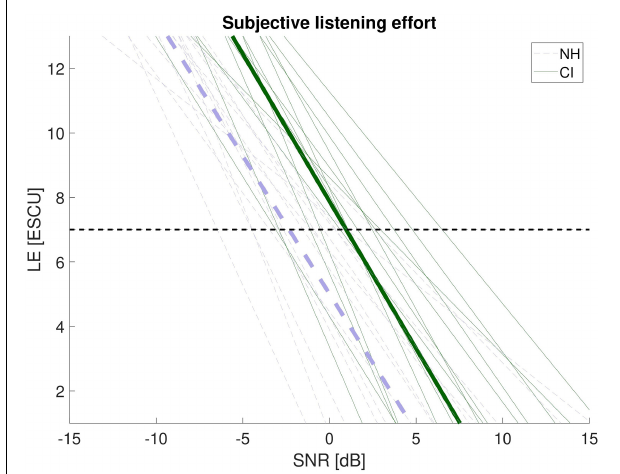
FIGURE 1 | Estimated speech recognition functions for the CI recipients (green) and the NH listeners (violet). Thin lines show individual functions, bold lines show the group mean. SNR = signal-to-noise ratio.